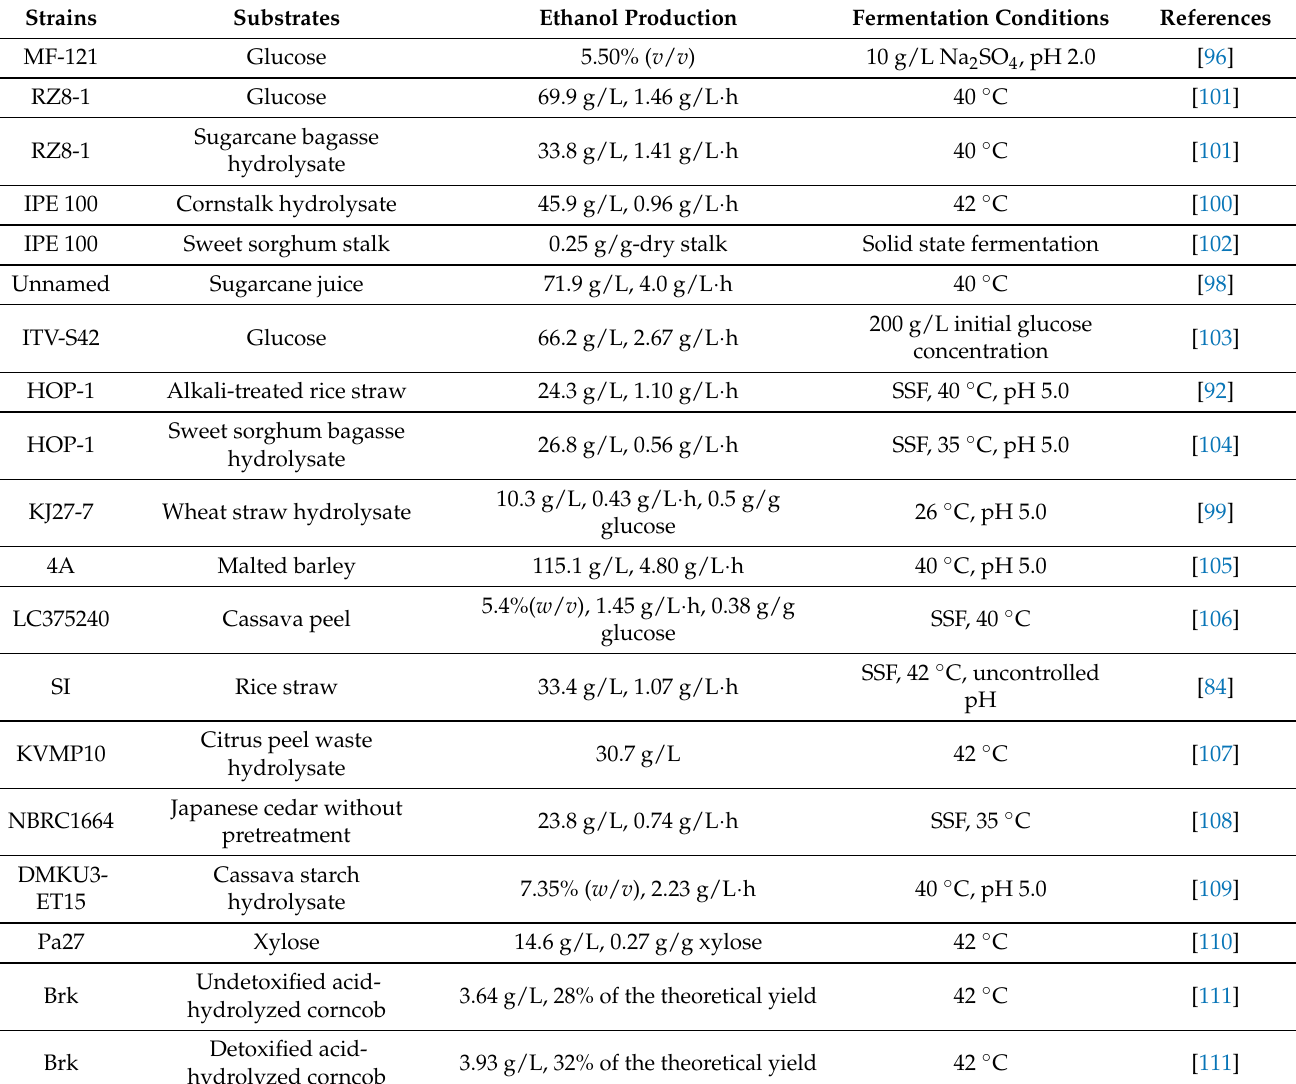
Table 2. Ethanol production by P. kudriavzevii strains under various